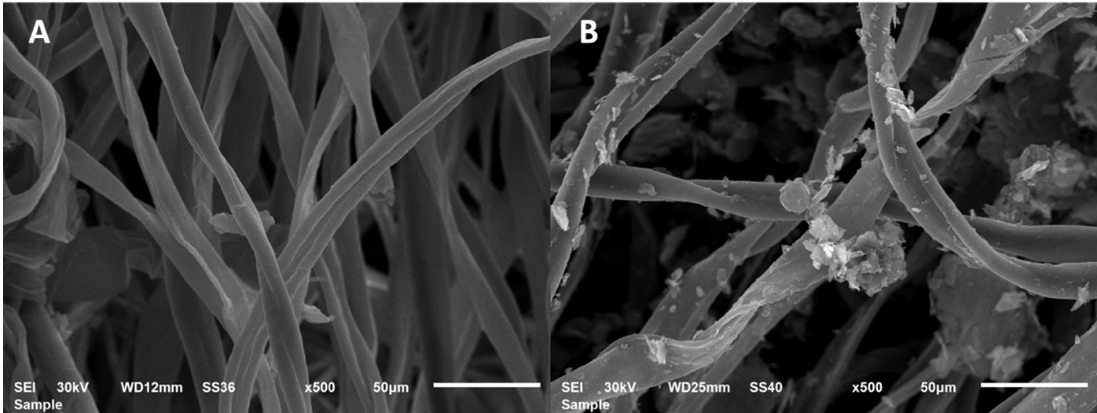
Figure 4. Morphology of untreated cotton ( A ) and graphite-based cotton ( B ).